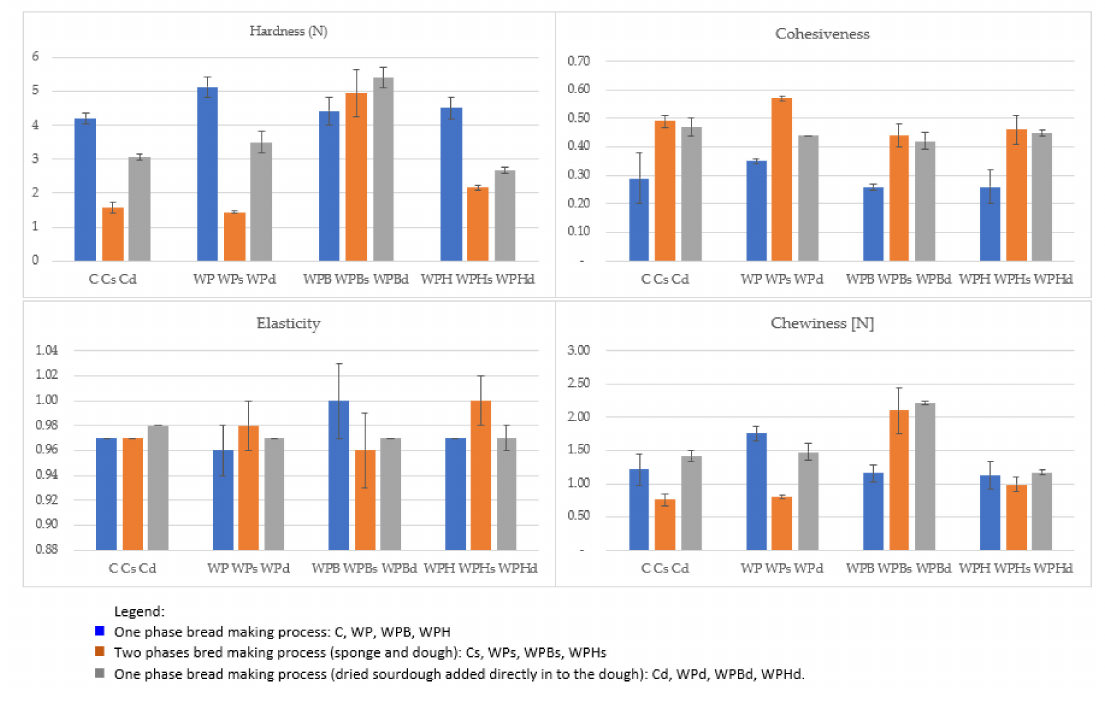
Figure 2. Texture properties of bread samples.